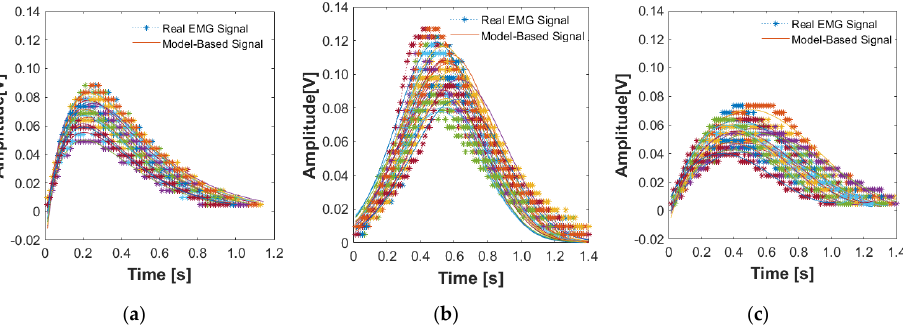
Figure 5. Real and model-based EMG signals with different amplitudes and time durations: ( a ) first movement; ( b ) second movement; ( c ) third movement.